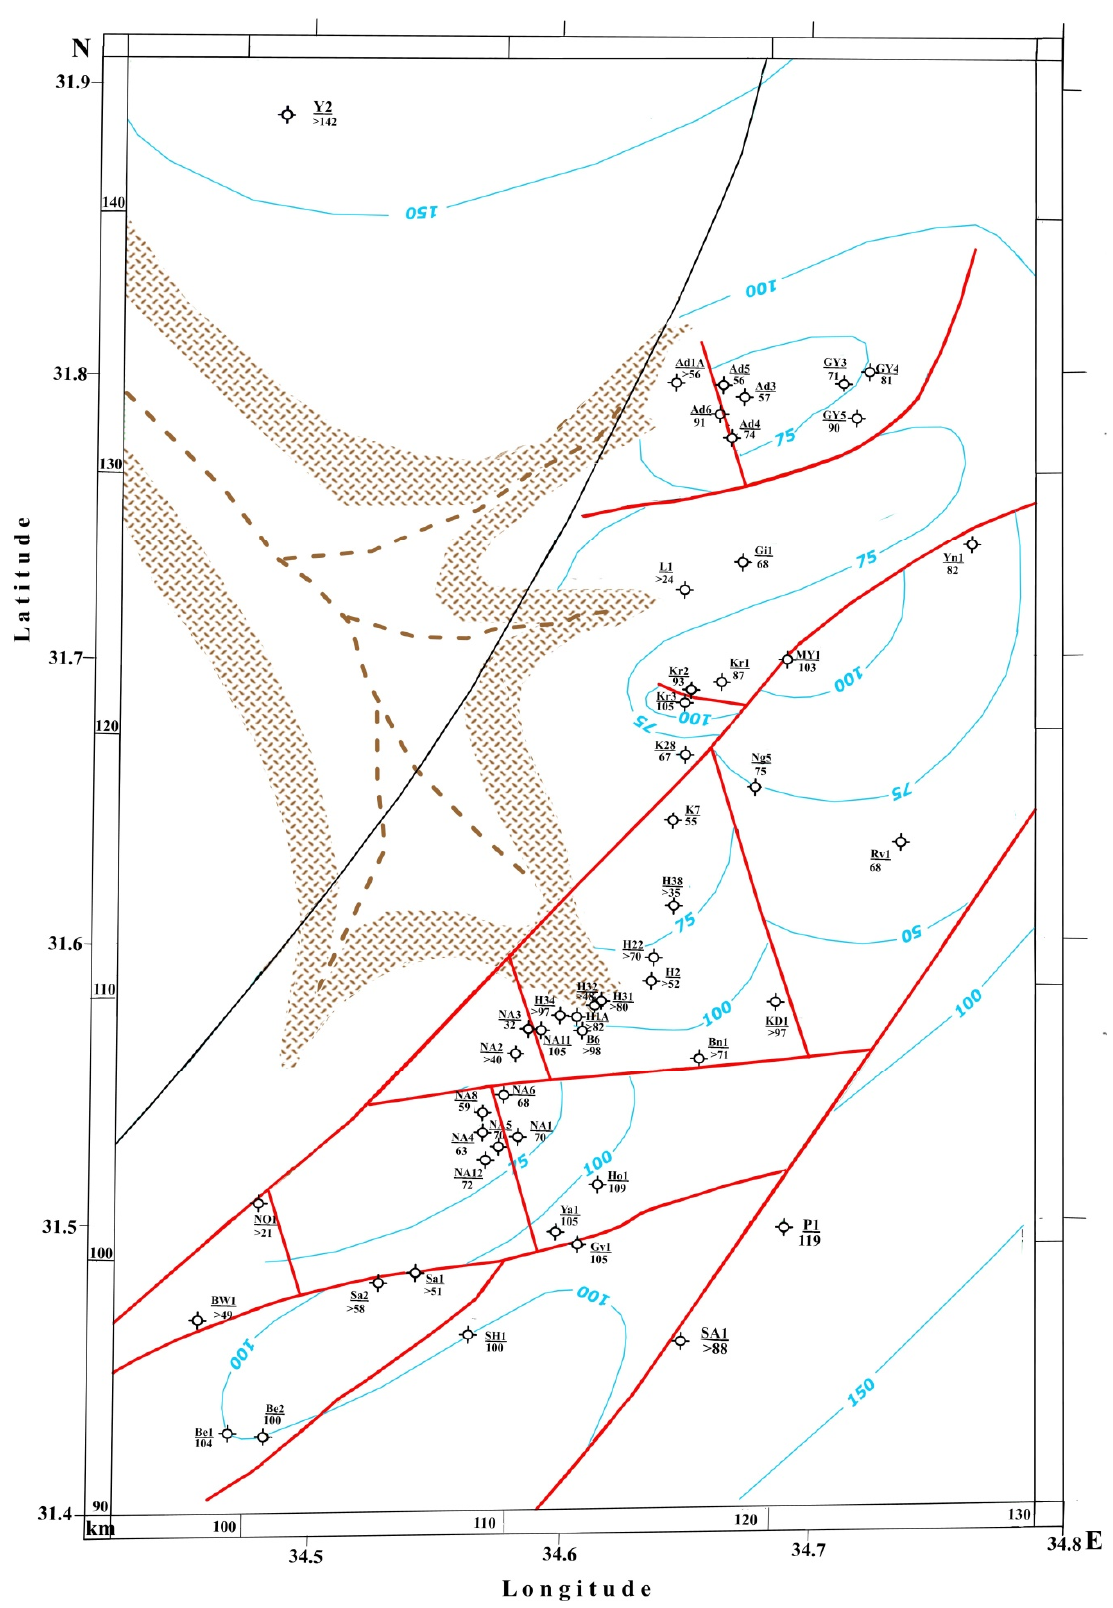
Figure 11. A map of the thicknesses of the Lower Callovian (Zohar Formation) of the Heletz–Ashdod oil field. The brown color shows the erosional canyon, and blue lines are the isopachs. Borehole abbreviations: see captions for Figure 2.